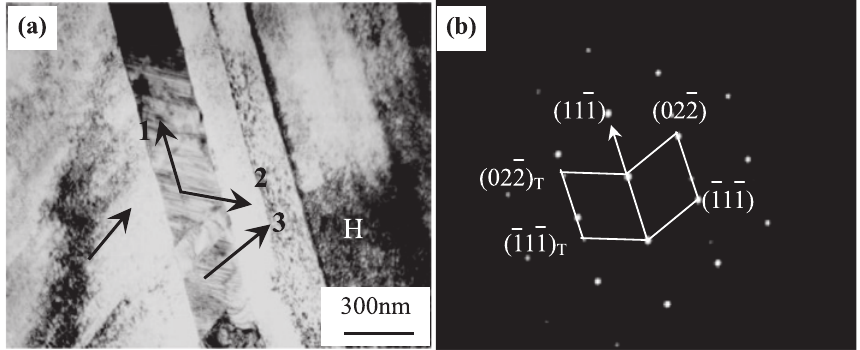
Fig. 5: Twinning deformation of GH4169 alloy after tension fracture. (a) Twinning, (b) SAED of